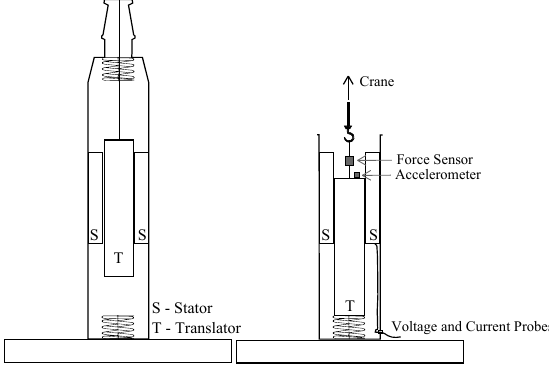
Figure 3. Sketch of the fully assembled generator (to the left) and experimental setup for the onshore tests (to the